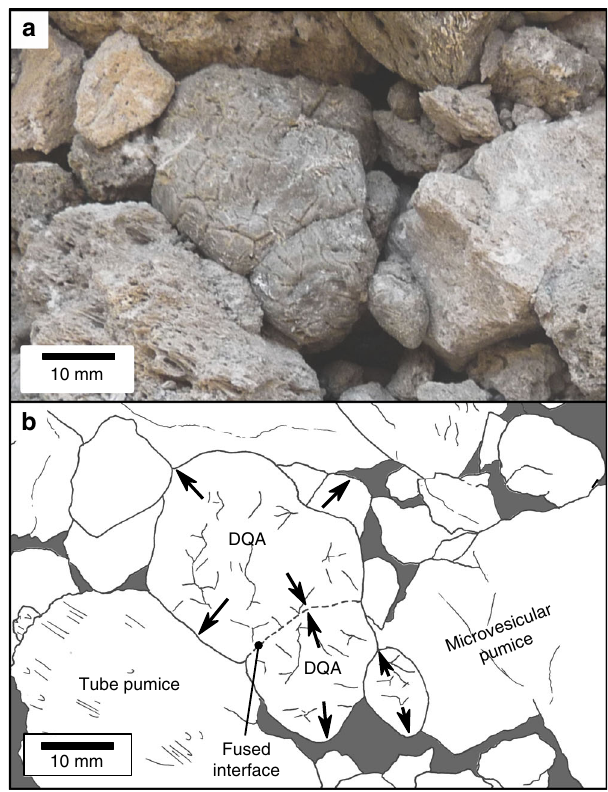
Fig. 3 Images showing the in-situ in fl ation of deposit quenched achneliths. a Image of deposit quenched achneliths, showing evidence of in situ in fl ation into void spaces between and against adjacent pumices. Note the polygonal form of the achneltih as a result of compression against adjacent clasts. b Annotated and line drawing of the same image. Arrows indicate the in fl ation of the DQAs. The central DQA is formed by the fusion of two adjacent DQAs, forming a single pyroclast